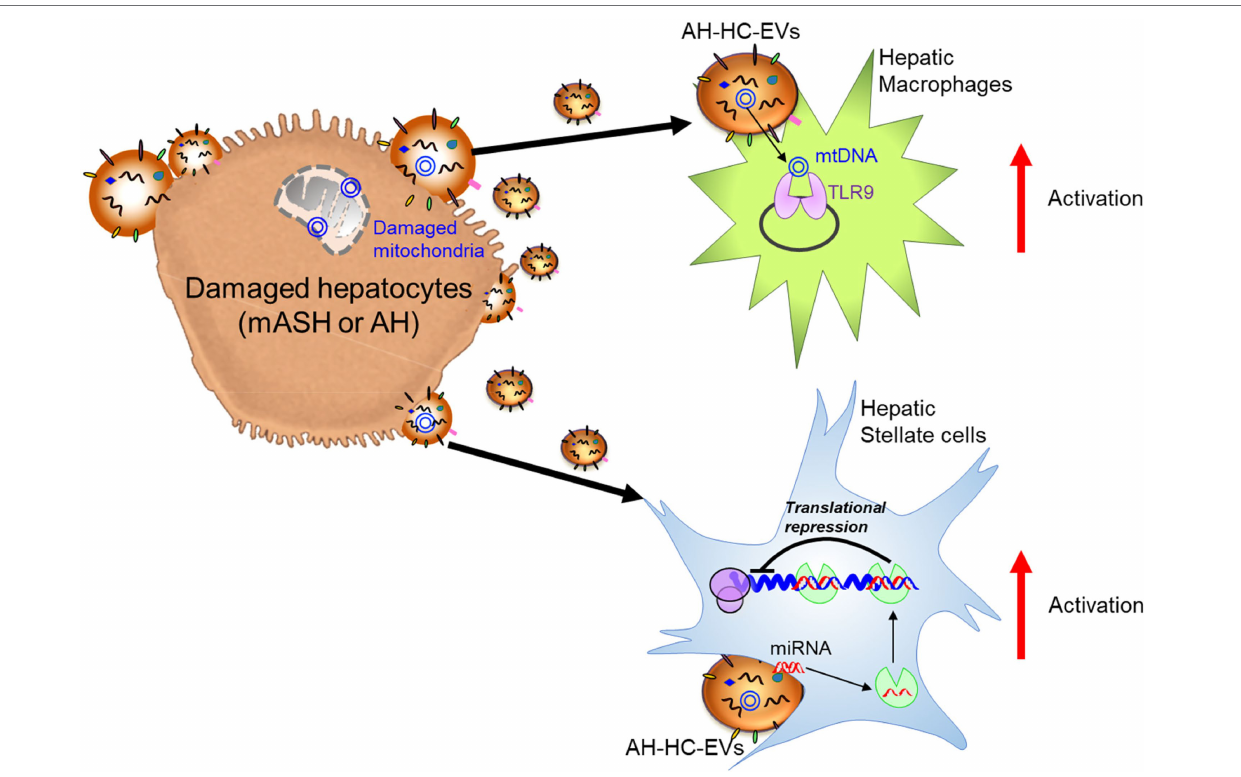
FIGURE 2 | Damaged hepatocyte released extracellular vesicles (EVs) and hepatocyte-derived EVs (HC-EVs) activate target cells with EV composition. Alcoholic hepatitis (AH)-HC-EVs may contribute the progression of diseases in multiple pathways; microRNAs (miRNAs) activate hepatic stellate cells through suppression of target genes and mitochondrial (mt)DNAs activate hepatic macrophages through toll-like receptor 9